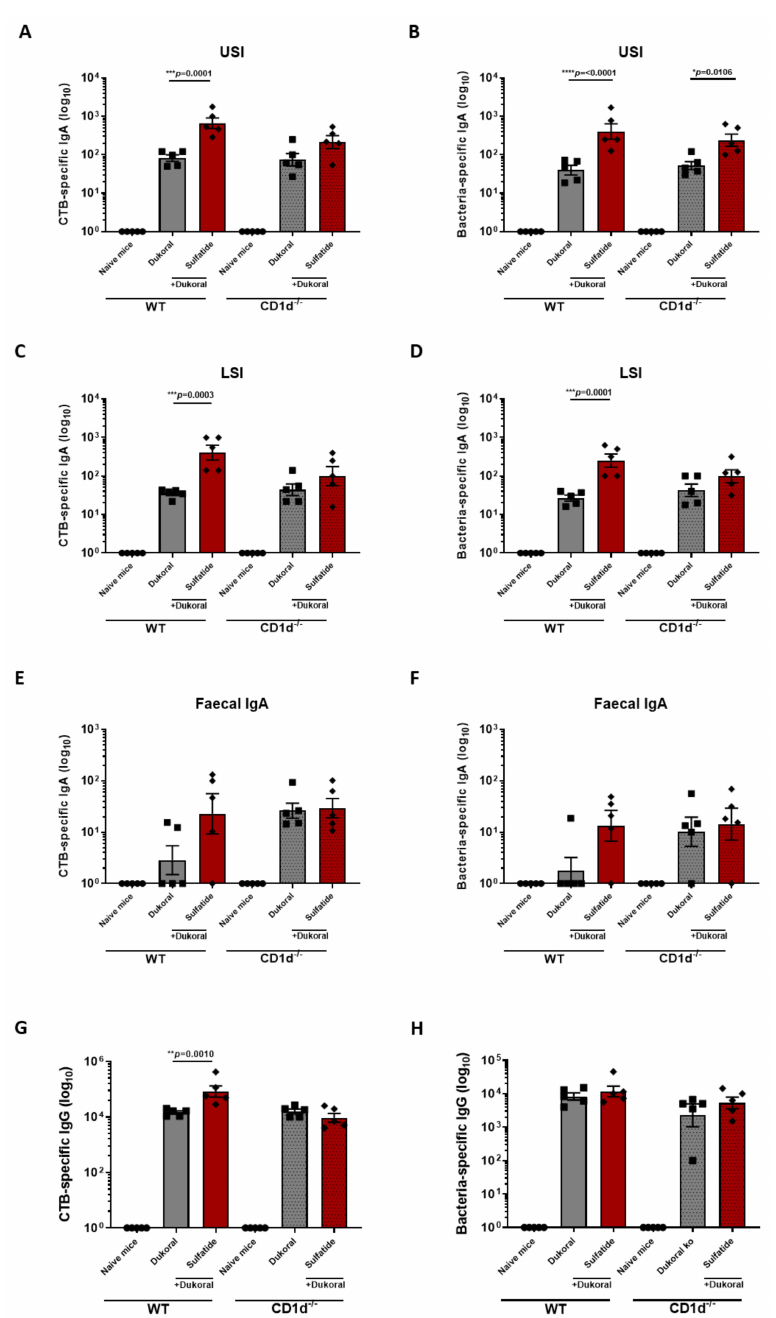
Figure 4. The enhancement of antigen-specific IgA and IgG responses by sulfatide is reduced in CD1d − / − mice. Female C57BL/6 WT and CD1d − / − mice were immunised orally with Dukoral ® co-administered with 80 µ g sulfatide in comparison with mice immunised with Dukoral ® alone or with PBS (naïve mice). Two weeks following the last round of immunisation, intestinal tissues, faecal pellets and blood were collected. Endpoint titres of CTB-specific IgA in upper small intestine (USI) ( A ), LSI ( C ), faecal pellets ( E ) and CTB-specific IgG in serum ( G ) were determined by ELISA. Similar analysis was performed to determine endpoint titres of bacteria-specific IgA in upper small intestine (USI) ( B ), LSI ( D ), faecal pellets ( F ) and CTB-specific IgG in serum ( H ). Results presented are mean titres ± SEM. Significant differences between the group of mice vaccinated with Dukoral ® alone and Dukoral ® co-administered with sulfatide are shown. Symbols show the groups of mice. Circles: naïve mice. Squares: mice immunised with Dukoral ® alone. Rhombus: mice immunised with Dukoral ® and sulfatide. Each symbol represents one animal in the